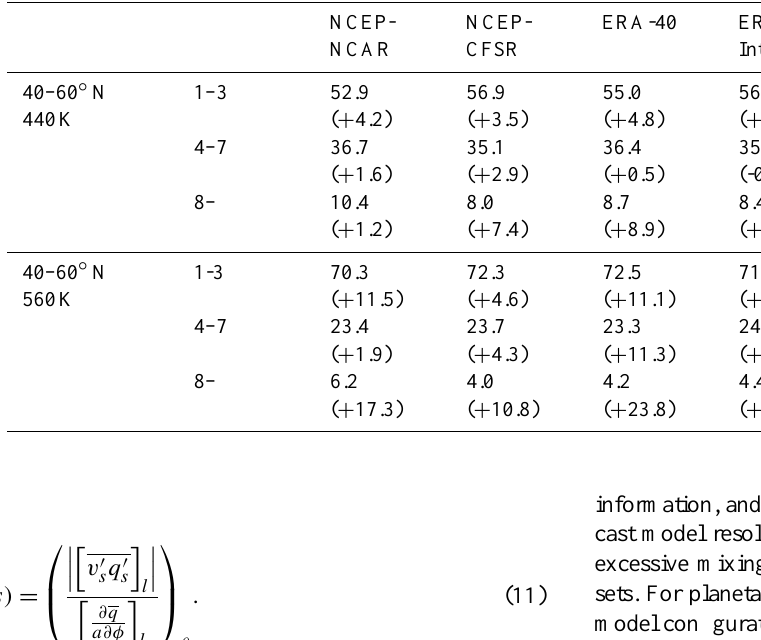
Table 6. Relative contribution of different wave components to the zonal eddy PV component (in %) and the linear trend slope (in %decade − 1 in brackets) averaged over 40–60 ◦ N at 440 and 560K in DJF in 1979–2012. None of the linear trend has a confidence level of